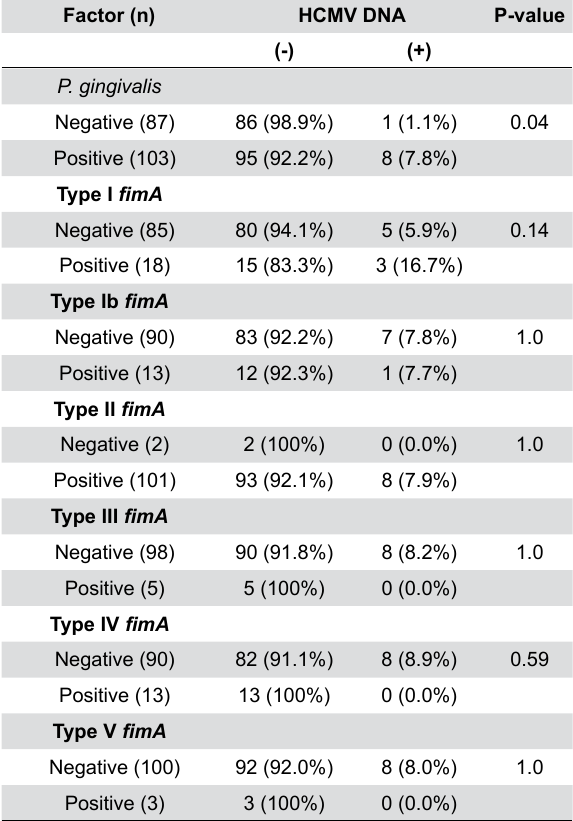
Propensity score-matching was performed between patients who had ≥4-mm-deep periodontal pockets with BOP (i.e., patients with active periodontitis) and those who lacked ≥4-mm-deep periodontal pockets Table 4- Associations of oral HCMV DNA with P. gingivalis and fimA